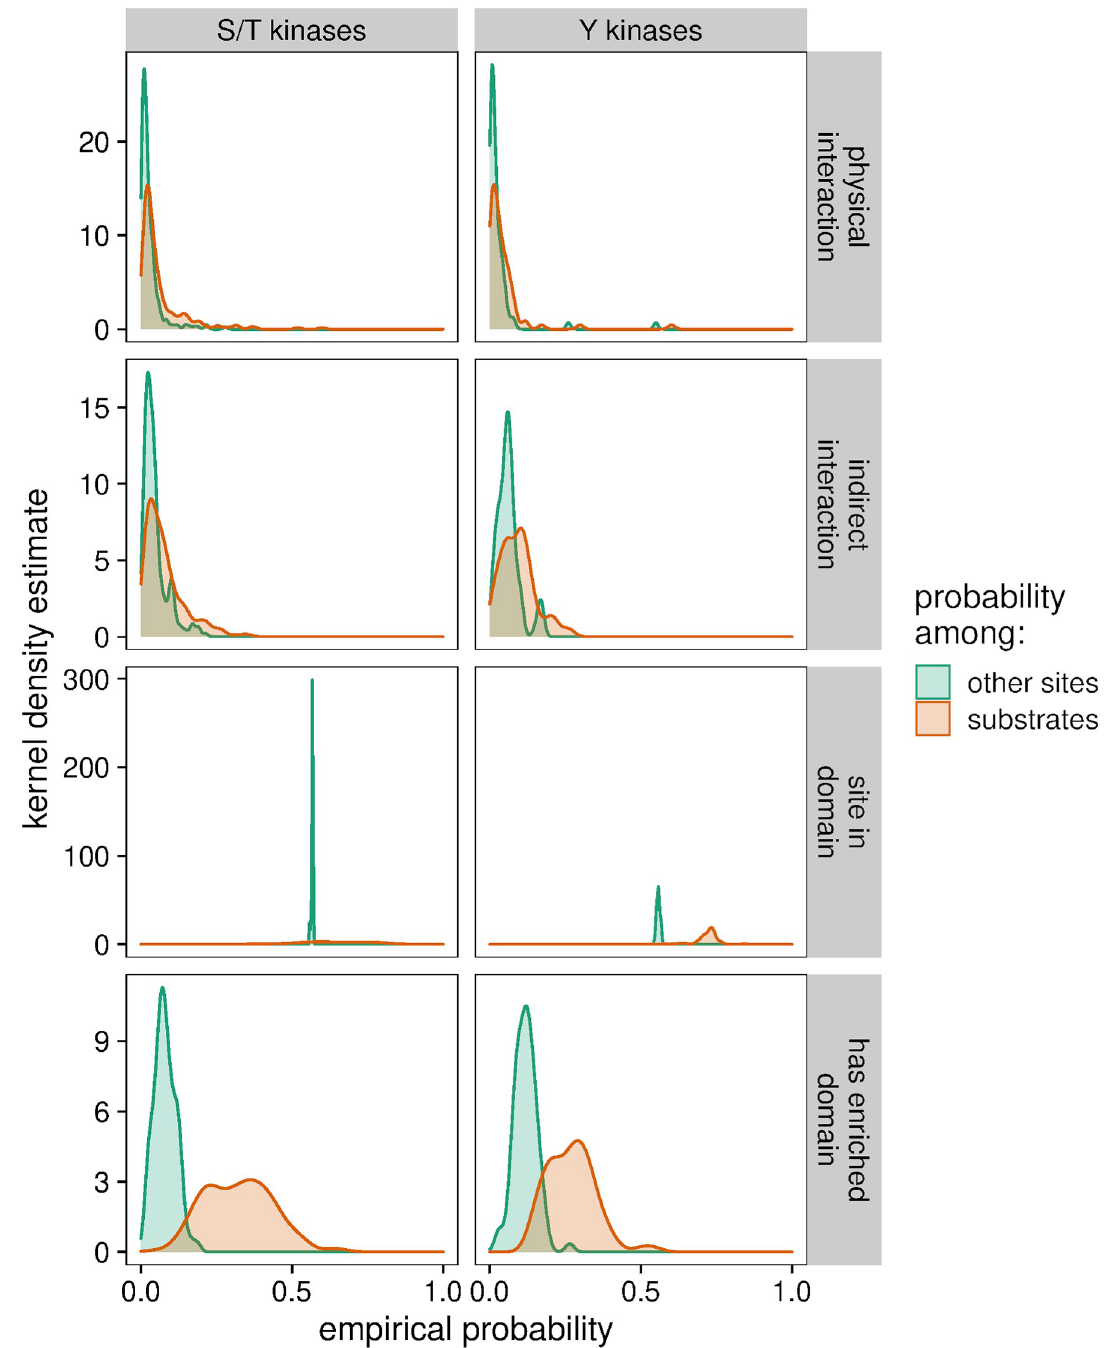
Fig 3. Additional predictive features of in vitro kinase substrates can be discriminated in the training data. Distributions of empirical probabilities are represented by the kernel density estimate of the kinases’ respective Bernoulli probability parameters. Each feature trends towards higher probability in in vitro substrates than in other